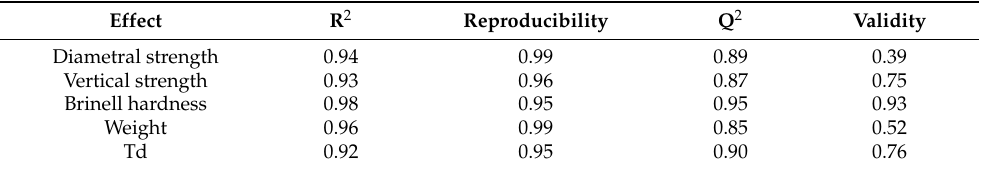
Table 2. Overview of the parameters from the models constructed for the Brinell hardness, diametral and vertical strength, weight and dissolution